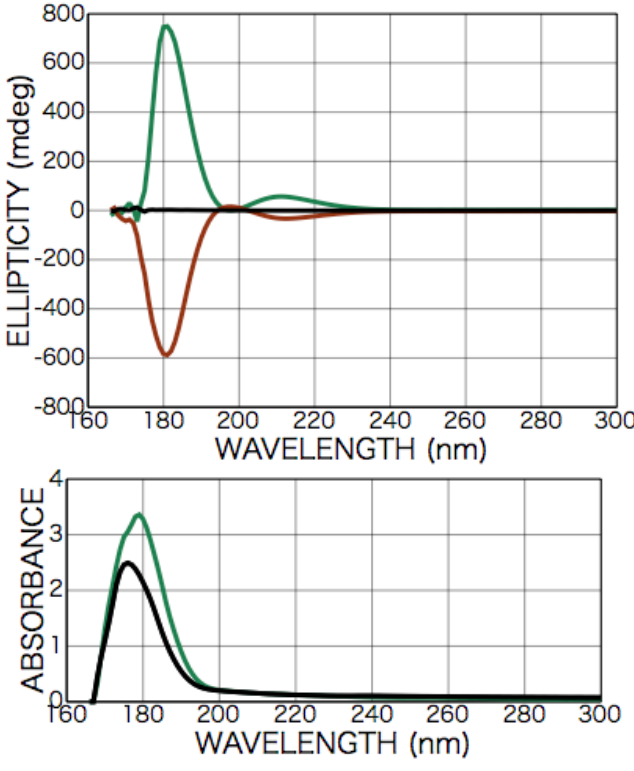
Figure 9. CD and photo absorption spectra of as-deposited D - (brown), L - (green), and DL -alanine (black) films (250-nm in